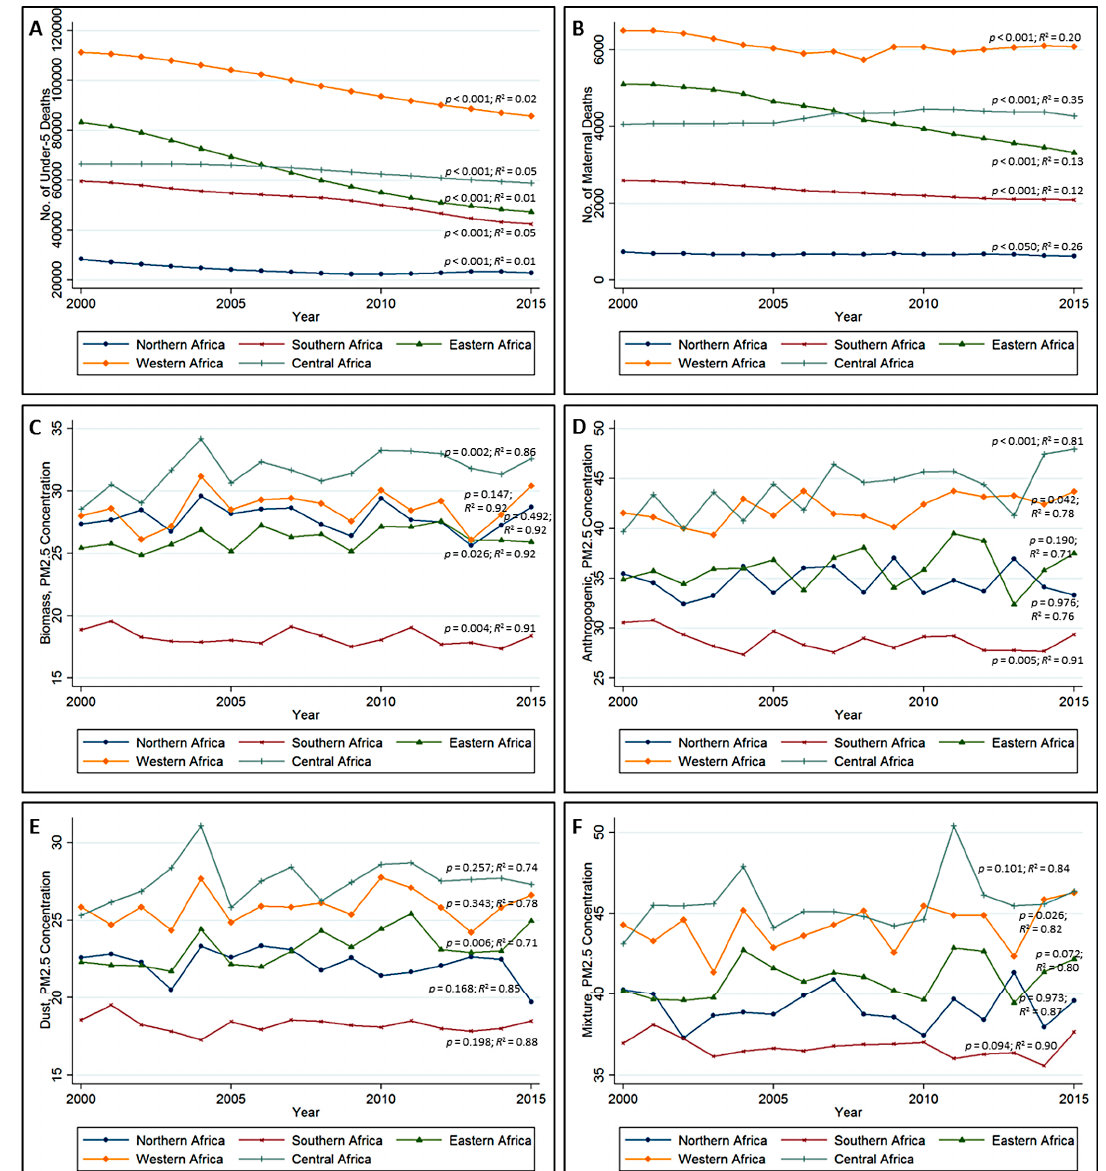
Figure 3. The annual mean trend of ( A ) under-5 deaths, ( B ) maternal deaths and ( C ) the PM 2.5 concentrations of biomass, ( D ) anthropogenic, ( E ) dust and ( F ) mixture by sub-regions of Africa. The GLMM with random intercept (country and year) was used to obtain the p-values of the change across the years. The GLMM with random intercept (country and year) was used to obtain the p -values and the R 2 .